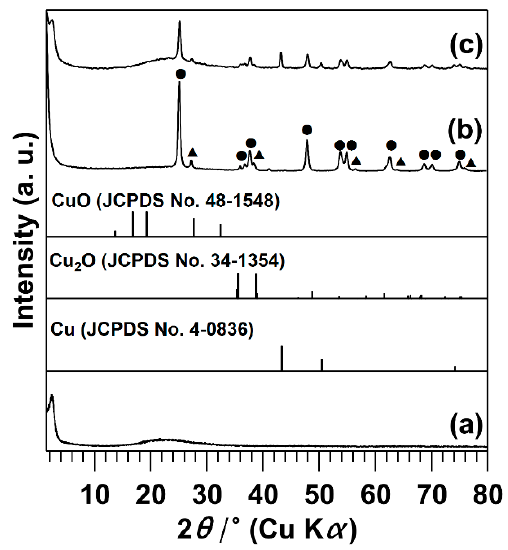
Figure 3. XRD patterns for ( a ) ASP, ( b ) P25, and ( c ) Cu–P25–ASP. Filled triangles and circles denote anatase and rutile reflections, respectively.